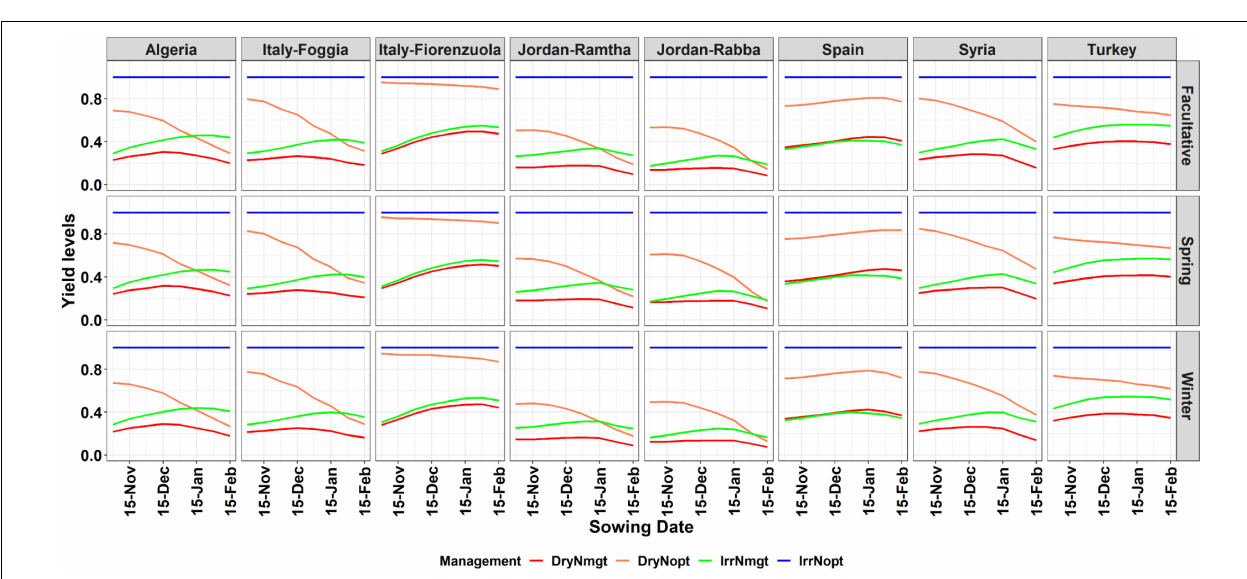
FIGURE 3 | Relationship between the decadal temperature trend and decadal heading date for the different genotypes (different line colors) and different sowing dates (PlDate, different shapes) for the facultative, spring, and winter barley types.